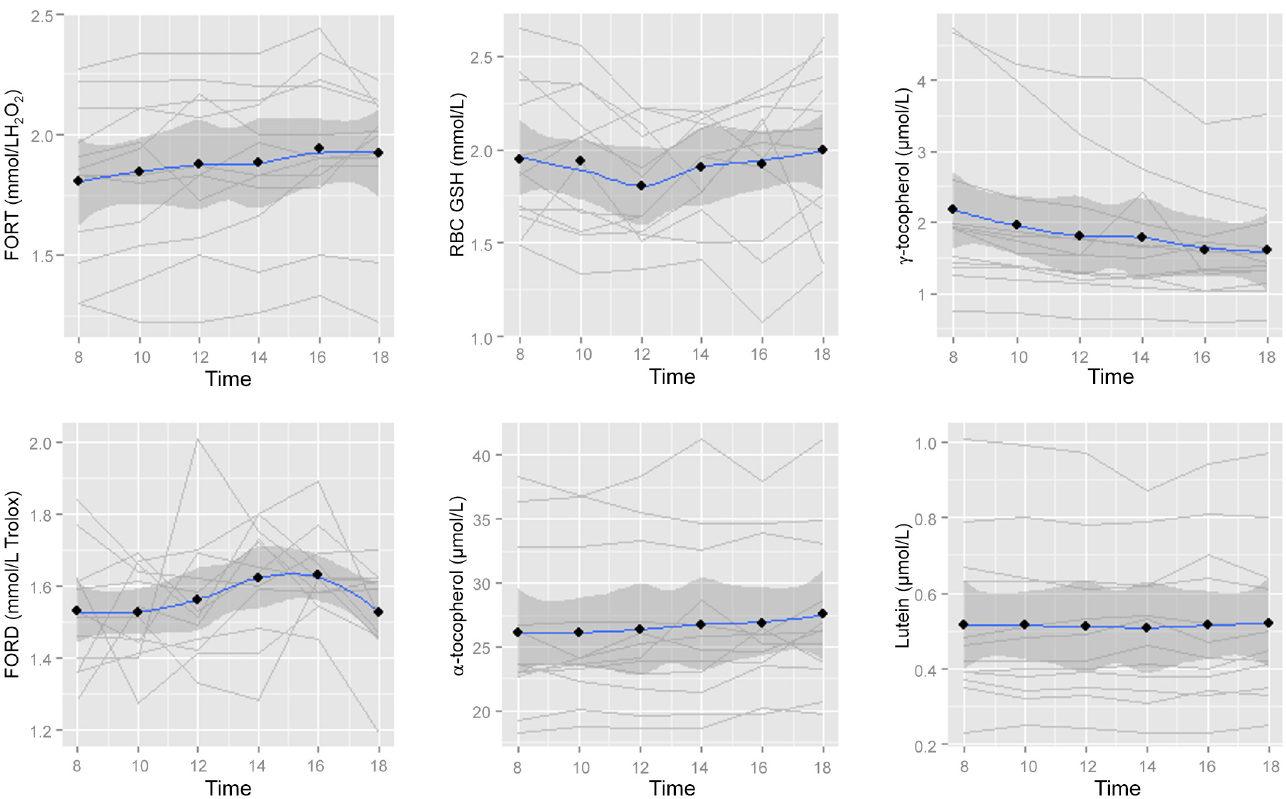
Fig 1. Case Profile plot of each biomarker over time with mean (black dot), smoothed trajectory (blue line) and 95% confidence interval displayed (dark shaded area).